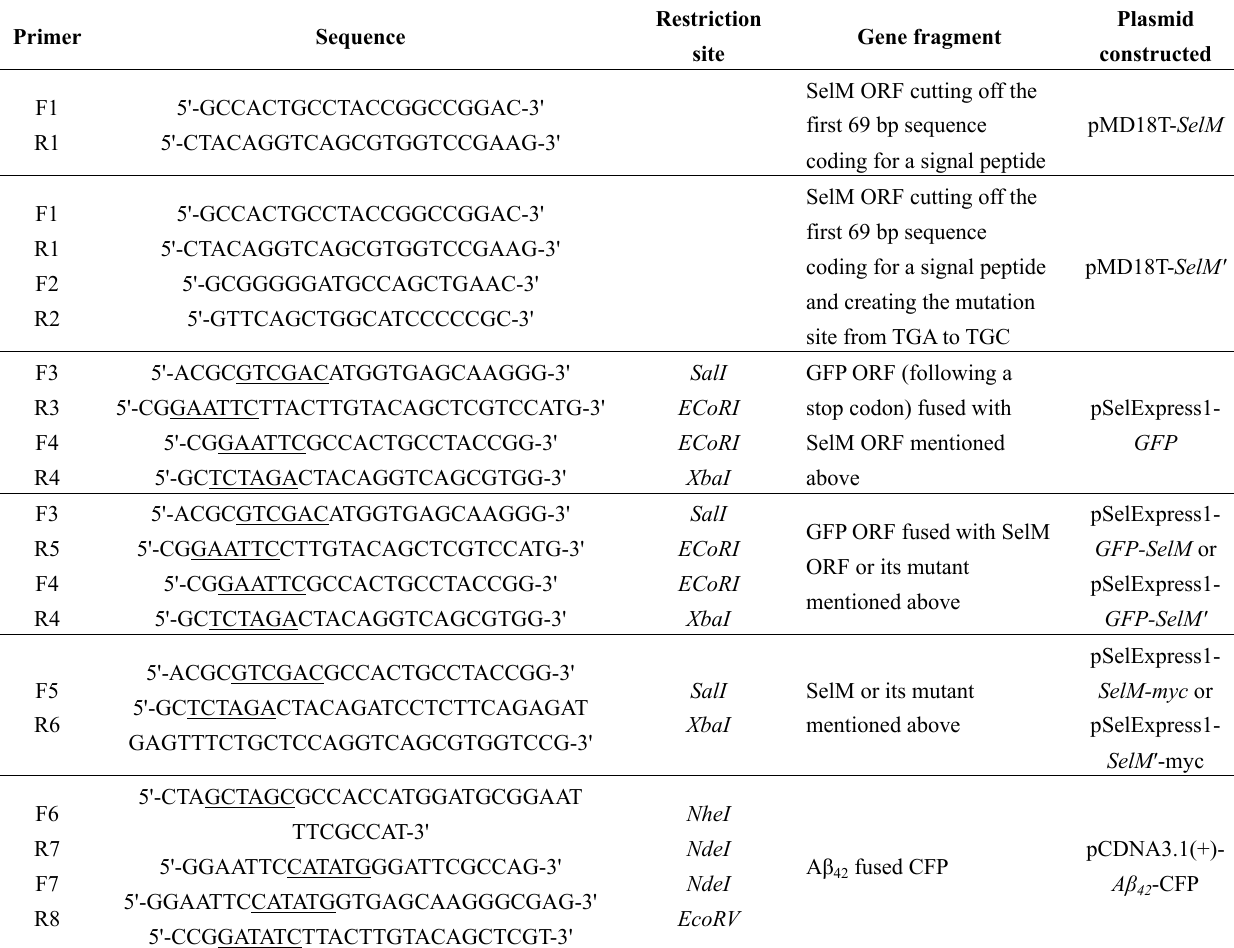
Table 1. Primers used and plasmids